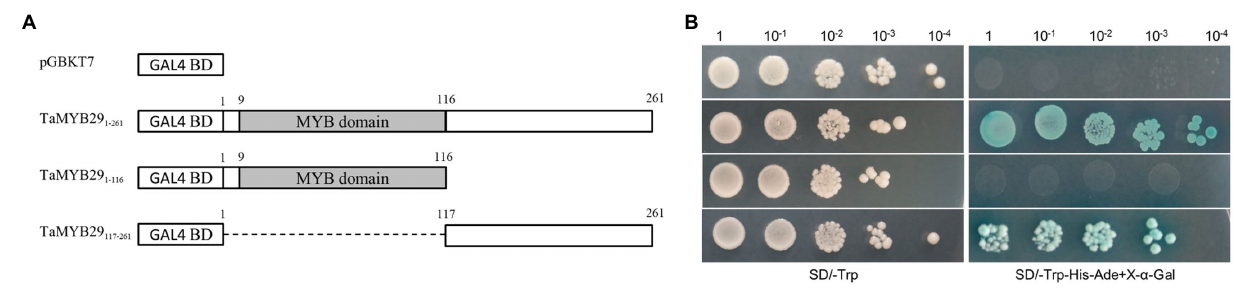
FIGURE 3 | Transcriptional activation activity of the TaMYB29 proteins. (A) Constructs of pGBKT7-TaMYB29 1–261 (full-length) and pGBKT7-TaMYB29 1–116 (N-terminal region), pGBKT7-TaMYB29 117–261 (C-terminal region), and pGBKT7 as a control were separately transformed into the yeast strain AH109. (B) The diluted yeast solutions were dropped on the SD/-Trp and SD/-Trp-His-Ade+X- α -Gal media, respectively; then, the cultures were incubated at 30 ° C for 3–4